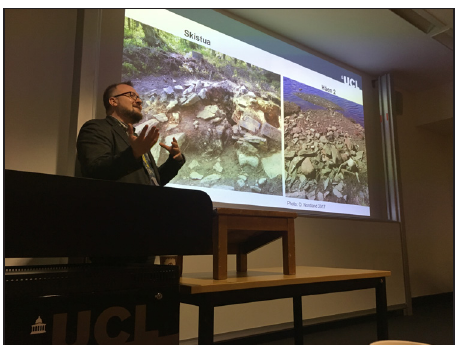
Figure 3: Ole Nordland, PhD candidate at the Institute of Archaeology, presenting on determining smelting temperatures from slag at the “Trial by Fire” conference (Photo: Lisa Monetti).